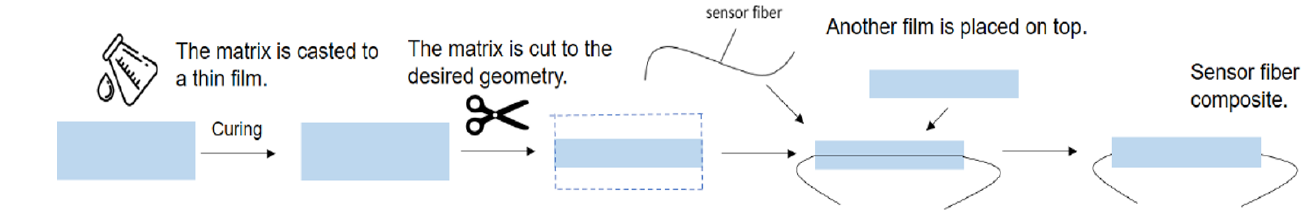
Figure 2. Steps for making ShSFC using the lamination